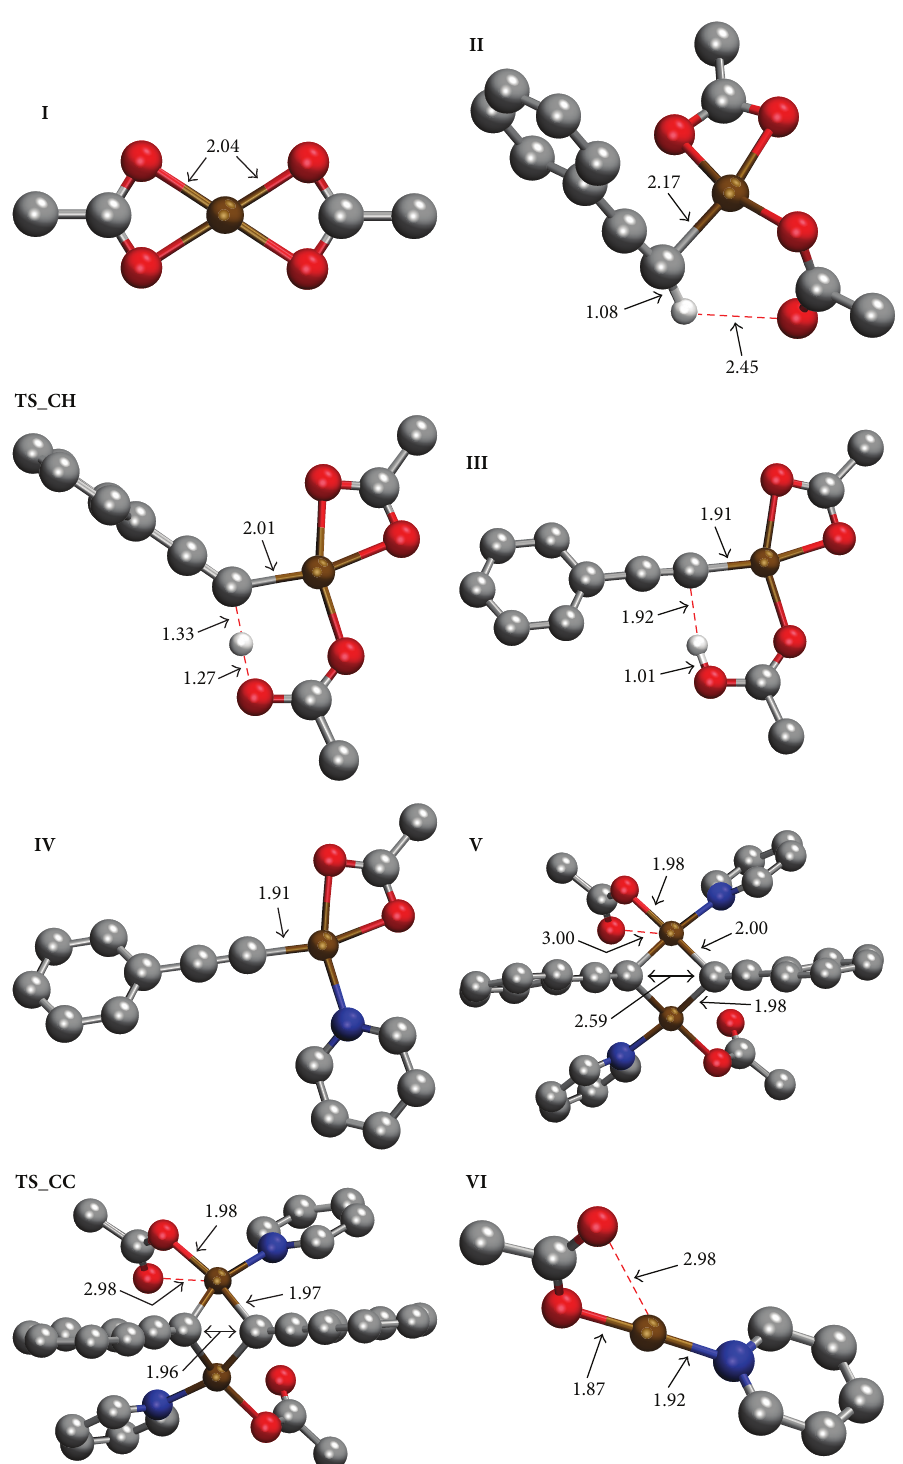
Figure 1: Detailed structures of V and TS CC (distances in ˚A, Cu = brown, N = blue, O = red, C = gray, and H = white; for clarity most H atoms have been